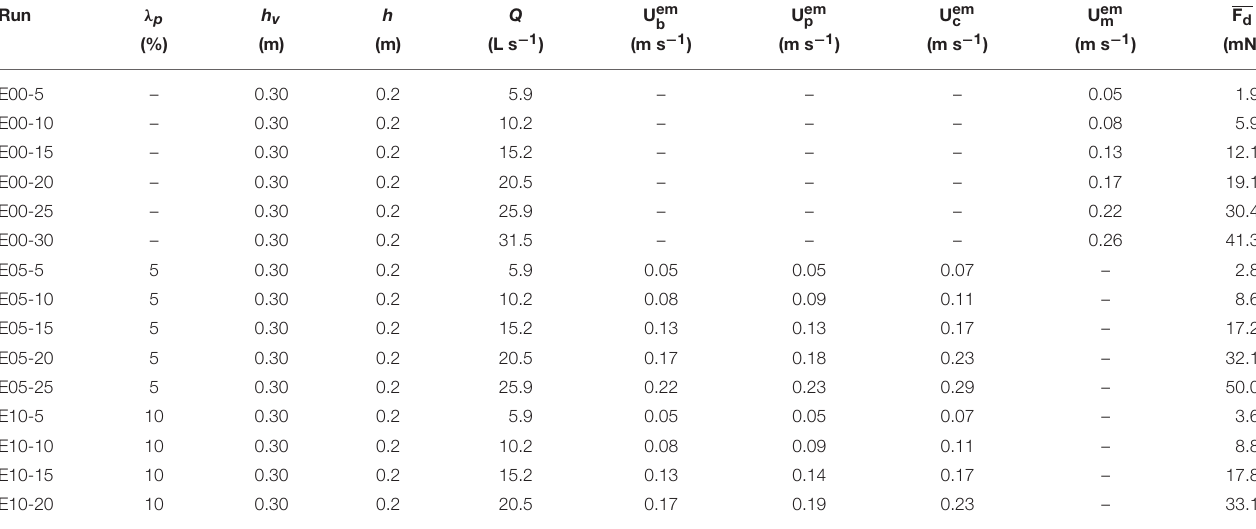
TABLE 1 | Experimental emergent vegetation conditions: canopy density ( λ p ), canopy height ( h v ), water depth ( h ), flow rate ( Q ), bulk velocity ( U em b ), pore velocity ( U em p ), constricted cross-section velocity ( U em c ), measured velocity averaged over the dowel height ( U em m ) and the measured time-averaged drag force acting on a single cylinder ( F d ).